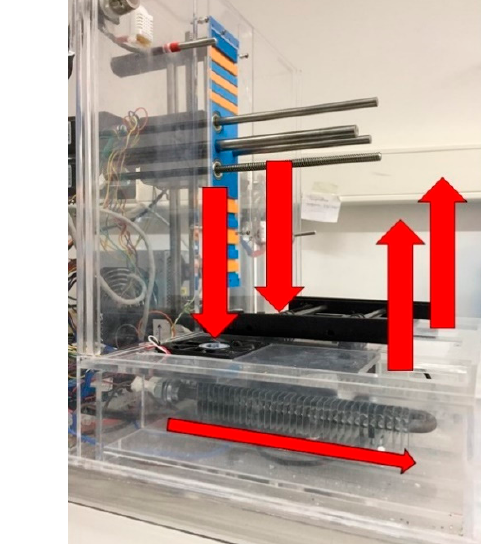
Figure 3. Air inlets/outlets schema.